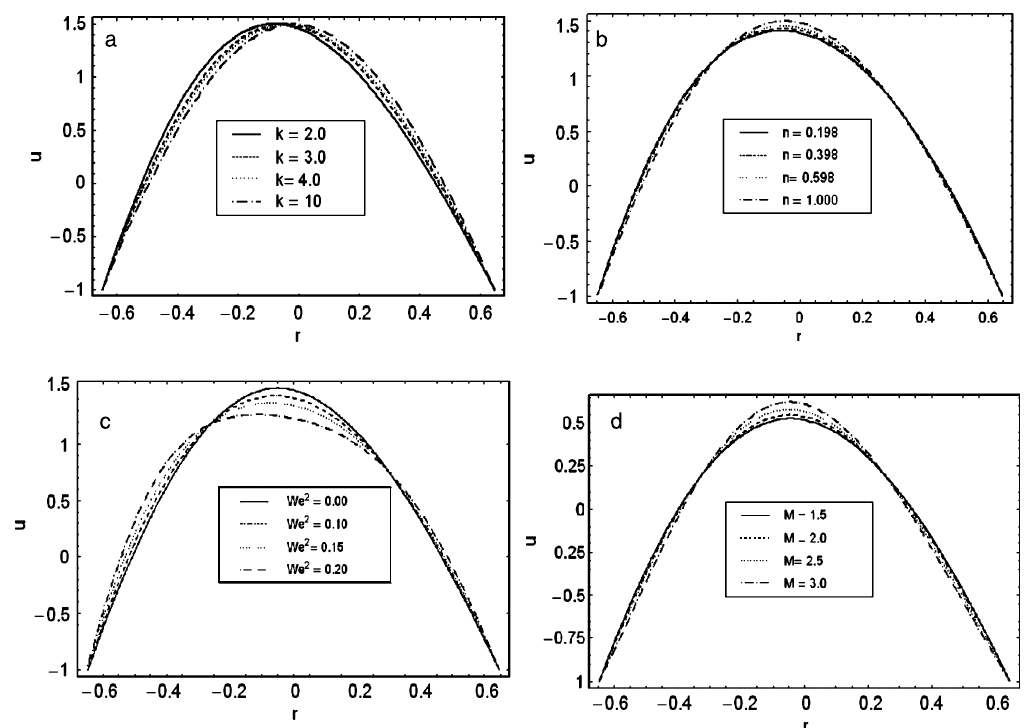
Fig. 3. (a) The axial velocity u versus r for α = 0 . 6, We = 0 . 02 ,θ = 2 . 8 ,x = 0 . 6 ,M = 1 . 9 and n = 0 . 398. (b) The axial velocity u versus r for α = 0 . 6, We = 0 . 1 ,θ = 2 . 8 ,x = 0 . 6 ,M = 1 . 9and k = 3 . 2.(c)Theaxialvelocity u versus r for α = 0 . 6 ,n = 0 . 398 ,θ = 2 . 8 ,x = 0 . 6 ,M = 1 . 9 and k = 3 . 2. (d) The axial velocity u versus r for α = 0 . 6, n = 0 . 298 ,θ = 2 ,x = 0 . 6 ,We = 0 . 02 and k = 3 .